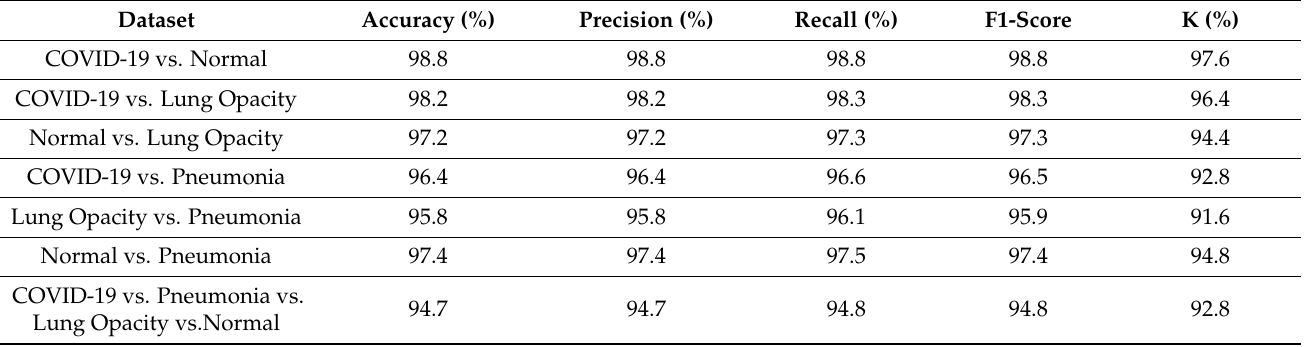
Table 3. Performance analysis of DCSCNN Model between binary and multiclass